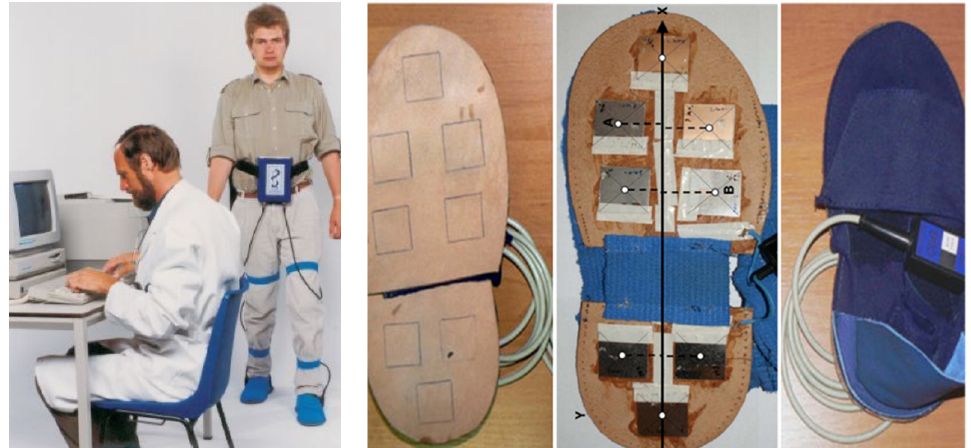
Figure 1. ( left part ) A normal subject wearing the shoes and the microprocessor recording the sig- nals of the eight force transducer signals. (two middle parts) Localization of the eight transducers in the plate of the shoes. ( right part ) A pair of shoes of the Ultraflex Infotronic ® system. For each single GRF-curve, the following amplitude parameters were extracted (see Figure 2): the amplitude of peak 1 (P1A), the amplitude of the midstance valley (V1A), and the amplitude of peak 2 (P2A). Furthermore, the difference from P1A to V1A (PD1), the difference from P2A to V1A (PD2), as well as the corresponding mean value (PD; PD1 + PD2)/2 (= P1A + P2A)/2-V1A were calculated. Further temporal parameters were as fol- lows: time to peak 1 (TP1), time to valley 1 (TV1), and time to peak 2 (TP2).